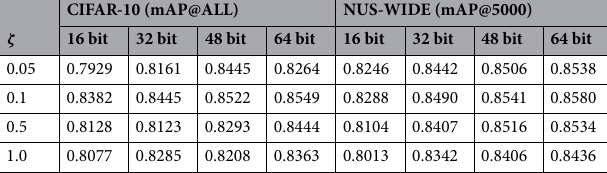
Table 3. mAP for of different ζ .